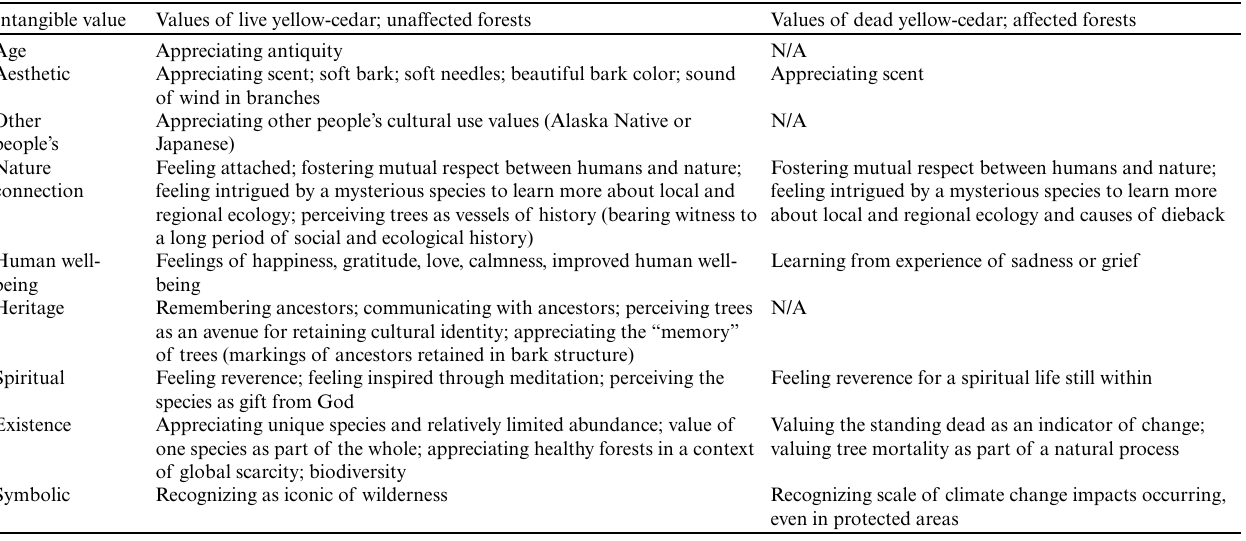
Table 5 . Reported intangible values for live yellow-cedar trees and unaffected forests, as distinguished by study participants from dead yellow-cedar trees and affected forests. Values listed are those that were discussed as past and present use values (arising indirectly or through nonuse), not hypothetical future use